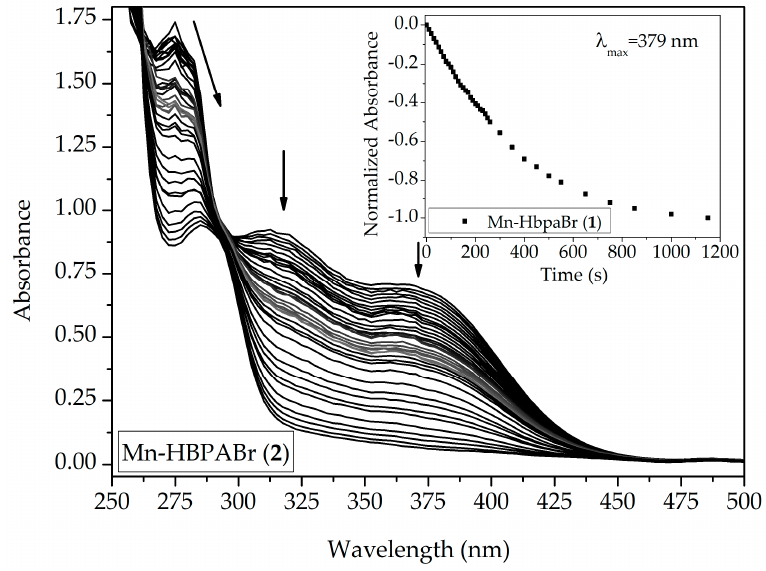
Figure 10. Changes in UV-Vis spectrum of ( 1 ) in dichloromethane (4.12 × 10 − 4 mol L − 1 ) during UV light irradiation ( λ em = 395 ± 5 nm). Inset: Normalized absorbance decay of ( 1 ) at 379 nm as a function of time (s) during light exposure.